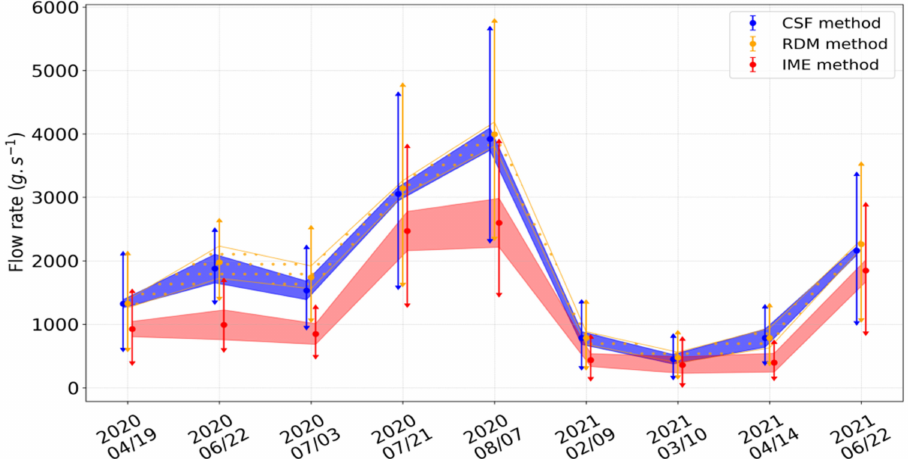
Figure 9. Temporal evolution of source A’s flow rate for the three methods: CSF (blue), RDM (orange) and IME (red). The points of the three colors represent the flow rate obtained with the mean mass per unit length and the mean effective wind (average of all the U ef f calculated with U 10 from Table 2). This mean effective wind speed can be interpreted as the wind value assuming no uncertainty. The areas in blue, in orange dotted and in red correspond to the uncertainty on the mean mass per unit length and the same mean effective wind speed. The arrow error bars cover maximum flow rate value uncertainty. They are calculated by combining the uncertainty on the mean mass per unit length and the extremes of U ef f derived from U 10 ± 1.5 m · s − 1